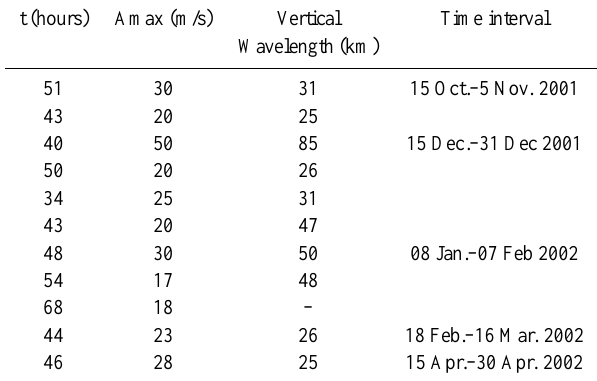
Fig. 12. Amplitude spectra calculated from the hourly values of the merid- ional winds measured at six altitudes during the interval 8 Jan.–7 Feb. 2002 (upper panel). The investigated peaks centred at 34, 43, 48, 54 and 67–70h are marked by arrows. Time-height cross section of the mean meridional wind observed during 15 Jan.–7 Feb. 2002 is shown on the lower panel.